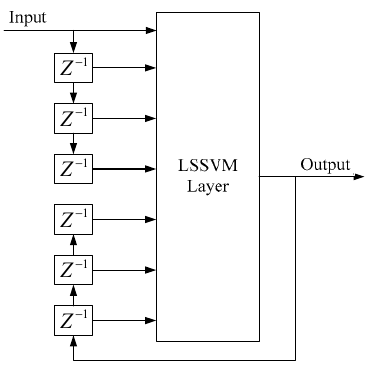
Figure 21. Structure of the LSSVM-NARX model. Figure 20. Structure of the LSSVM ‐ NARX model.